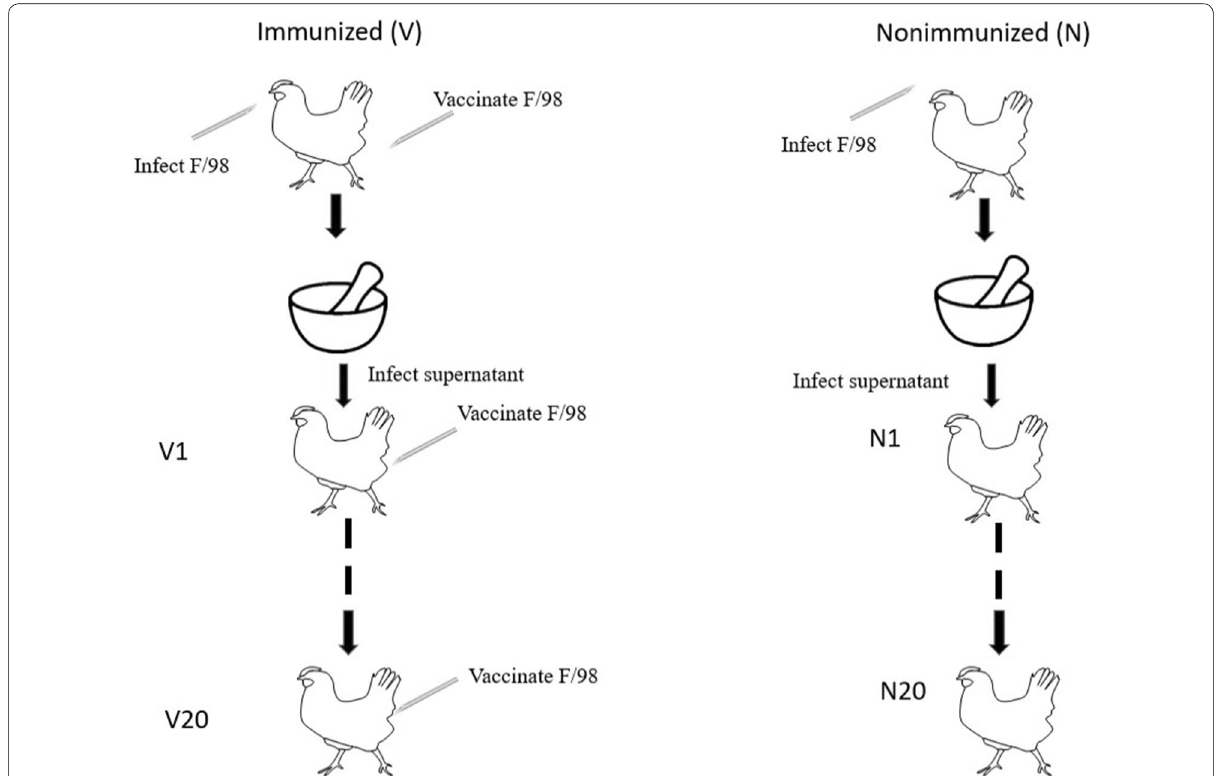
Fig. 1 The schematic diagram for F/98 serial passaging under selective pressure with and without vaccine